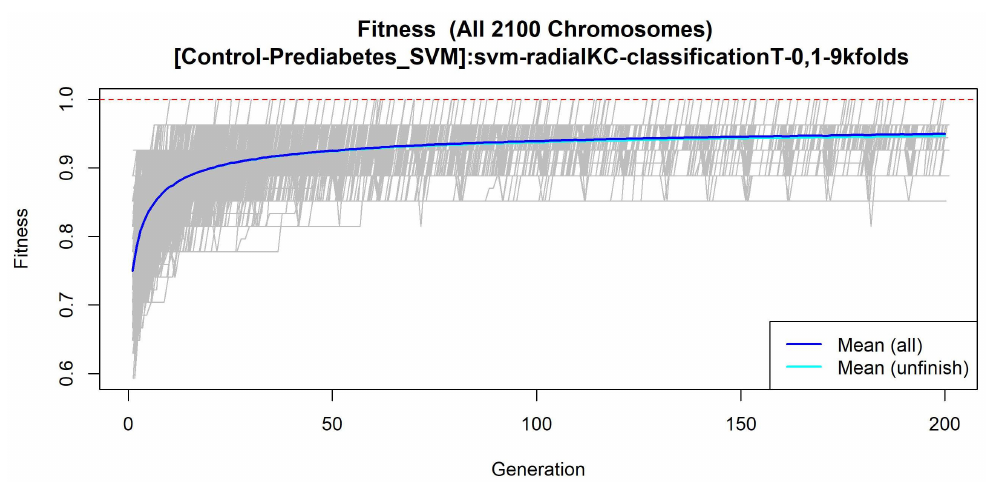
Figure 3. Gene frequency and gene rank stability in the models are ascertained by applying GA with SVM to select the main features from the Control-Prediabetes dataset. ( A ) The gene frequency allows observing the number of times each feature appears in the models. ( B ) The gene rank allows observing the stability and frequency of each feature within the models and orders them by rank.